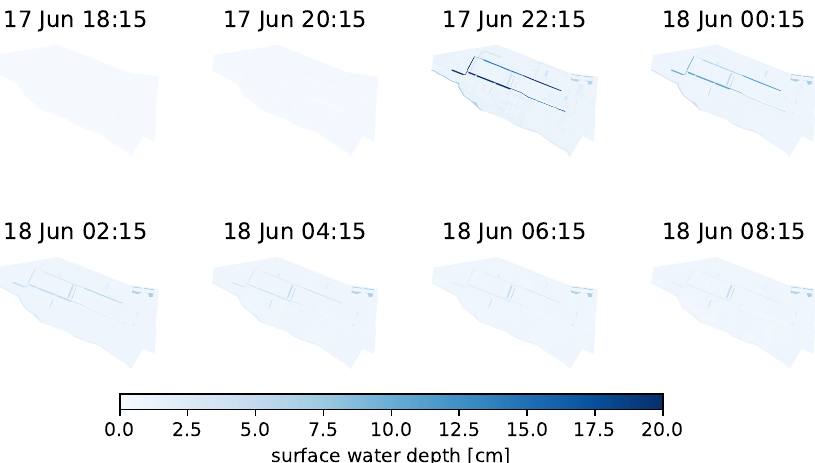
Figure 5. Spatial distribution of surface water depth for different time steps of event #1 (June 2011). Maximum runoff occurs around 22:15.